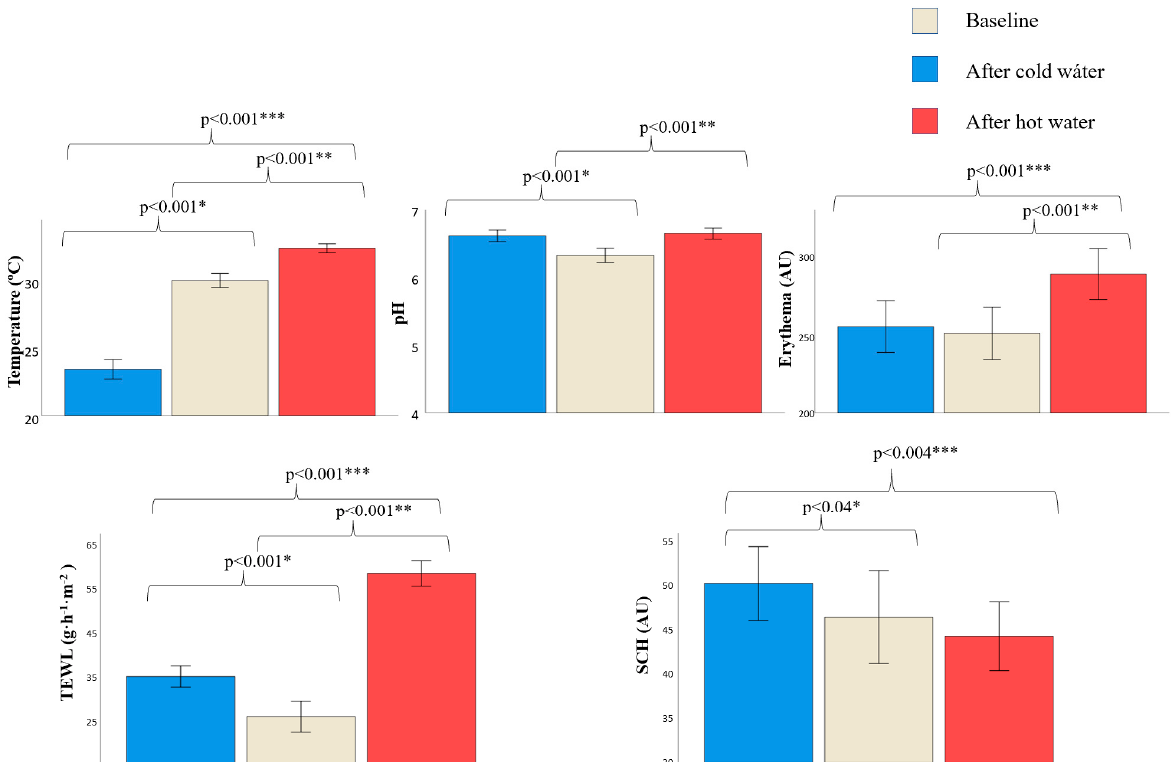
Figure 3. Skin barrier function parameters on the hands at baseline and after hot and cold-water exposure. Data is expressed as mean (standard deviations). AU, arbitrary units; SCH, stratum corneum hydration; TEWL, transepidermal water loss. * p -value after using Student’s t-test for paired samples to compare skin barrier function between baseline and after cold water exposure. ** p -value after using Student’s t -test for paired samples to compare skin barrier function between baseline and after hot water exposure. *** p -value after using Student’s t -test for paired samples to compare skin barrier function after cold and hot water exposure. Only significative p -values are shown ( p <